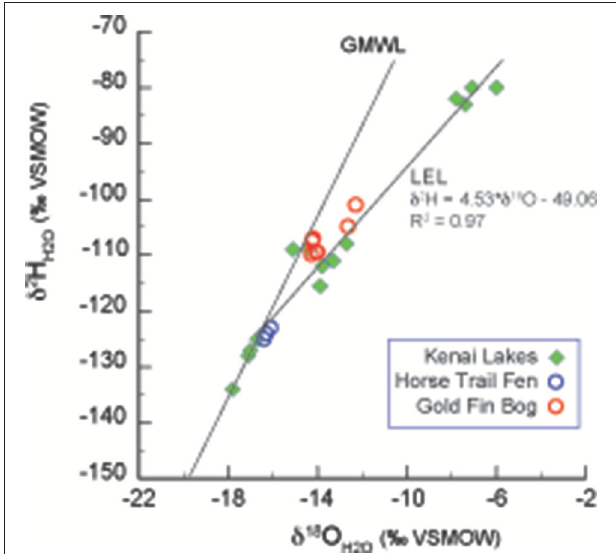
FIGURE 2 | Lake water oxygen and hydrogen isotopes from the Kenai Peninsula, AK (green diamonds; Figure 1 and Table 1 ) were used to form the Local evaporation line (LEL) which is shown with the global meteoric water line (GMWL; Rozanski et al., 1993), and with surface waters from Horse Trail fen (HTF, Table 2 , open blue circles), and Goldfin (GF, Table 3 , open red circles).